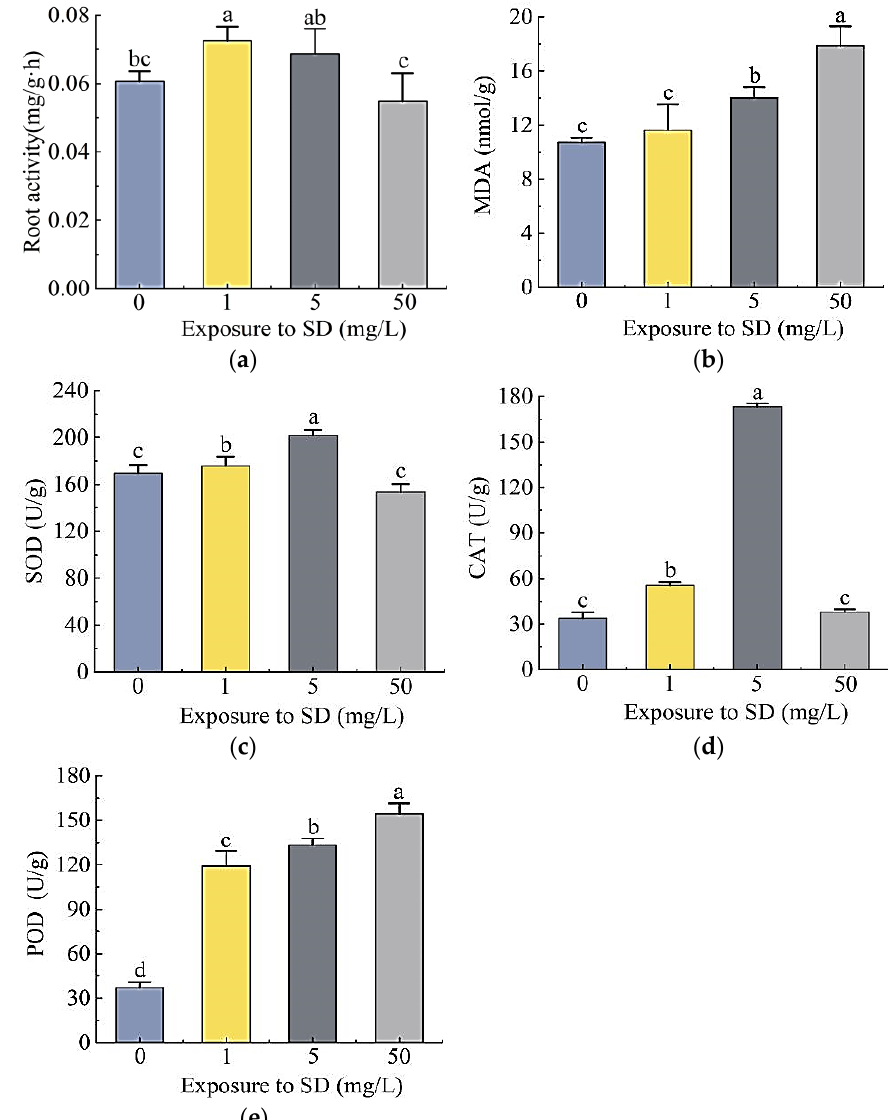
Figure 3. Effects of different concentrations of SD (0, 1, 5, and 50 mg/L) on root activity ( a ), leaf MDA ( b ), SOD ( c ), CAT ( d ), and POD ( e ) activities of S. portulacastrum . Data are mean ± standard deviation ( n = 6). Different letters above the bars represent significant differences based on Duncan’s Multiple Range test at p < 0.05 level.